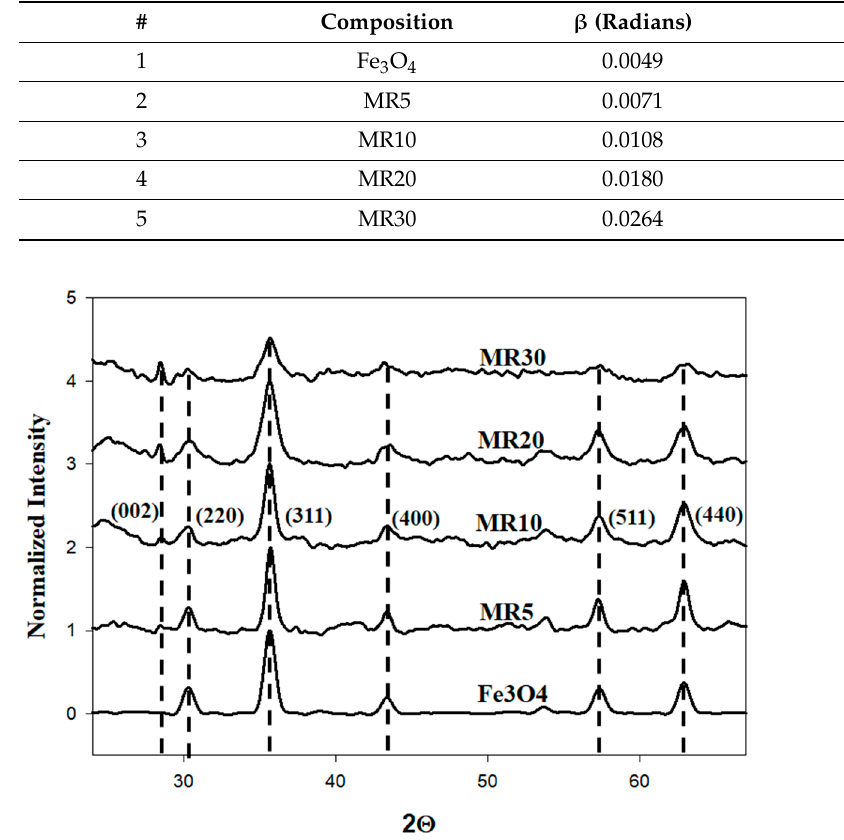
Figure 2. The XRD spectra for Fe 3 O 4 , MR5, MR10, MR20, and